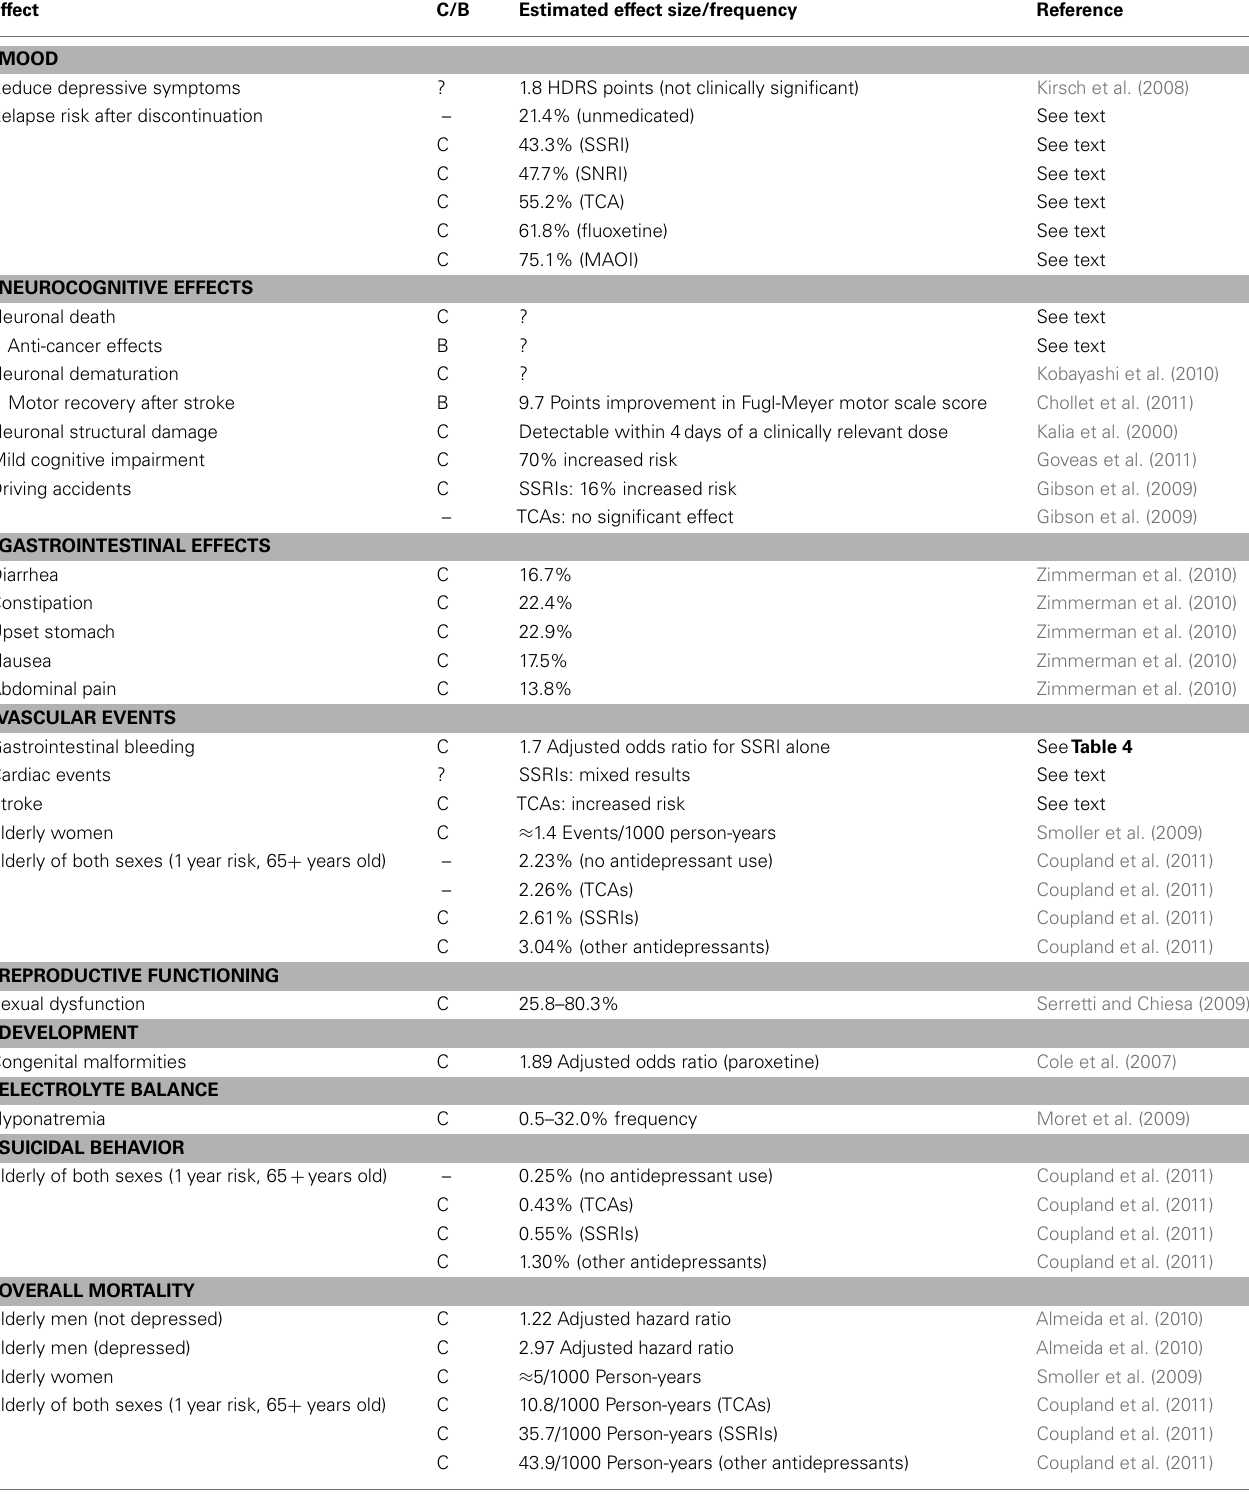
Table 2 | Summary of costly (C) and beneficial (B) effects of antidepressant medications, with some estimate of their effect size or